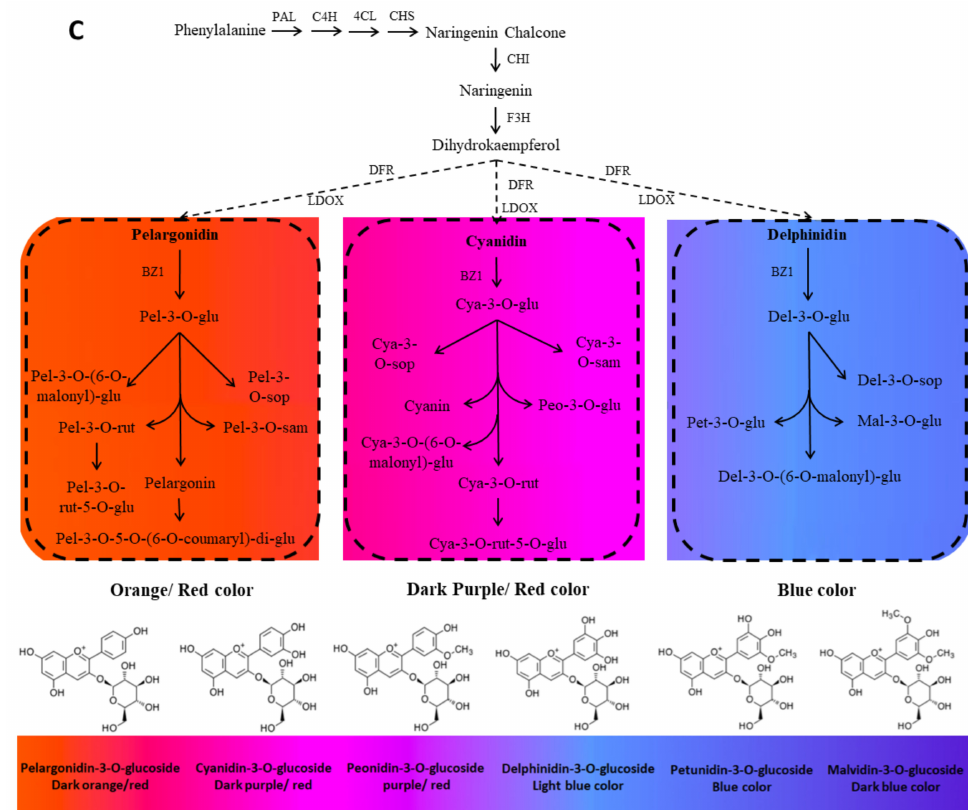
Figure 4. Venn diagram and anthocyanin biosynthesis pathway in sugarcane. ( A ) Represents the interactive Venn diagram of anthocyanin data of six species; ( B ) Characterizes the Venn network of anthocyanin data of ROC22 (red), YT71/210 (dark purple), and YT93/159 (green) rind sugar- cane genotypes; ( C ) Signifies comprehensive anthocyanin biosynthesis pathway based on quan- tified anthocyanin metabolites from sugarcane rind. Gene abbreviations were taken from KEGG (www.genome.jp/kegg/pathway; Assessed on 5 December 2021) for plants. PAL: